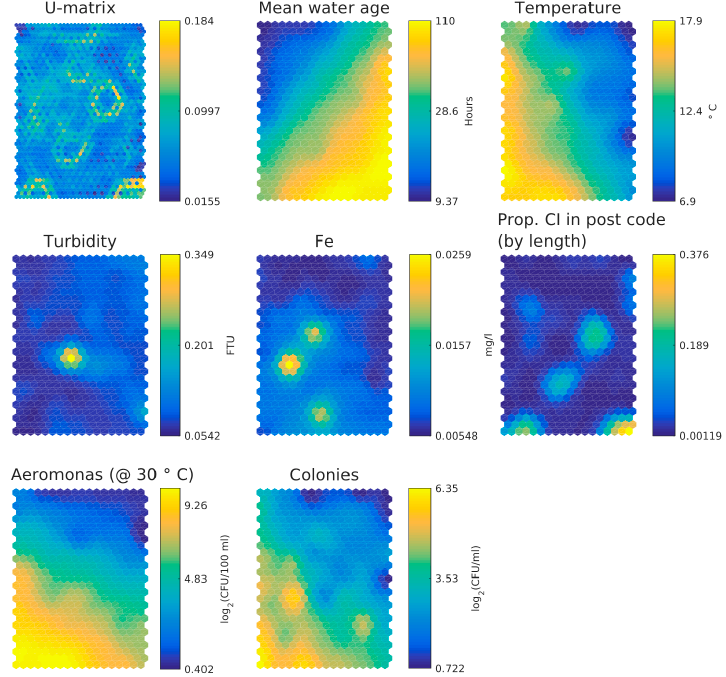
Figure 7. SOM component planes for only WTW Andijk in the Dutch dataset.